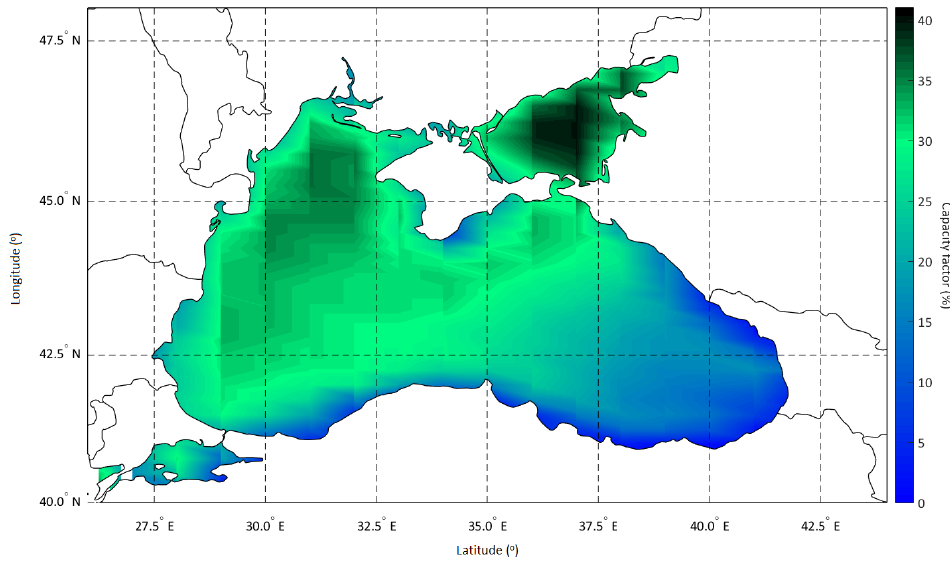
Figure 13. Airborne 5 MW — capacity factor (in %) expected for the U414 wind conditions.